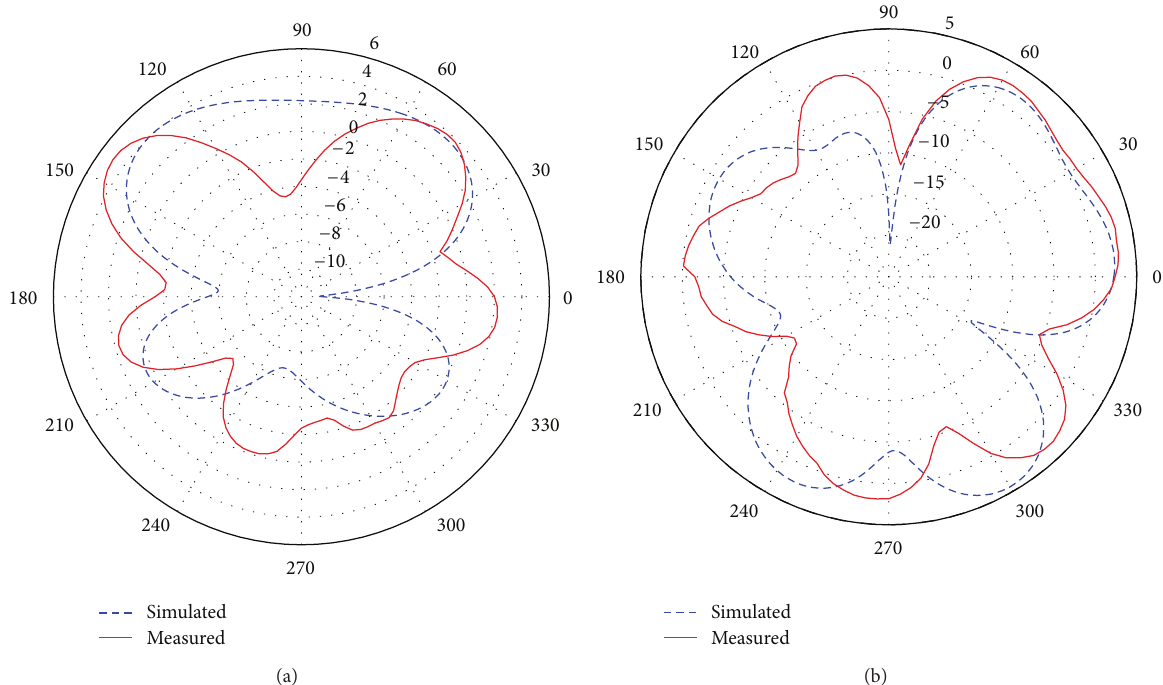
Figure 18: Comparison of numerical and experimental gain pattern cuts at 5.4GHz recorded at the principal planes (a) 𝜙 = 0 and (b) 𝜃 = 𝜋/2 . Notice the different radial scales (both are given in